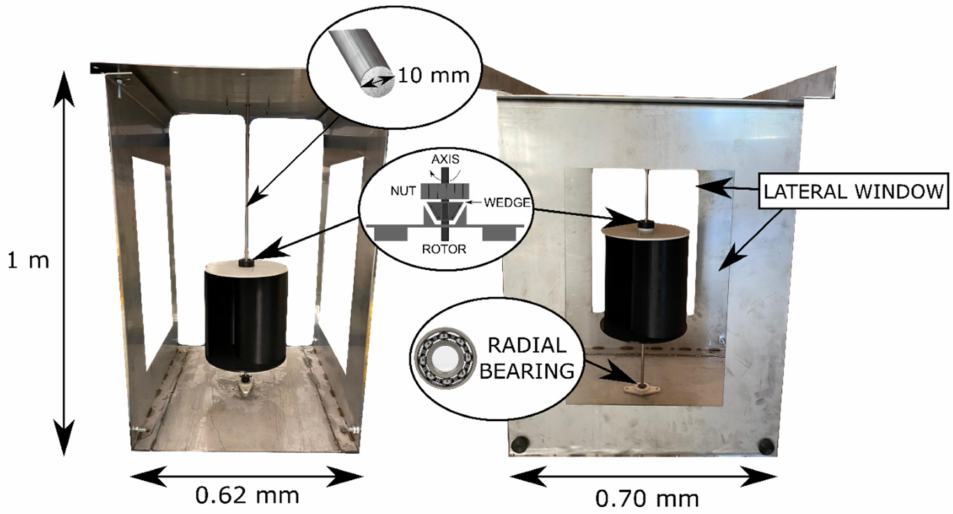
Figure 2. Structure used to couple the different rotor designs.